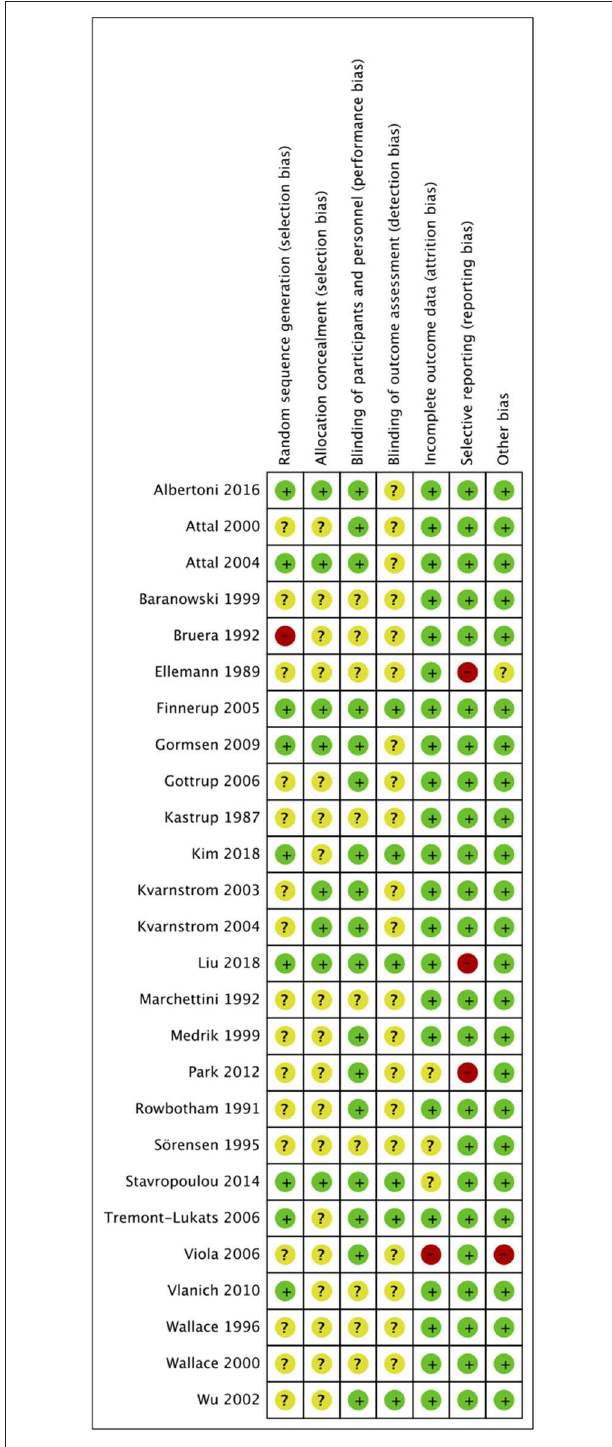
FIGURE 2 | Risk of bias summary.